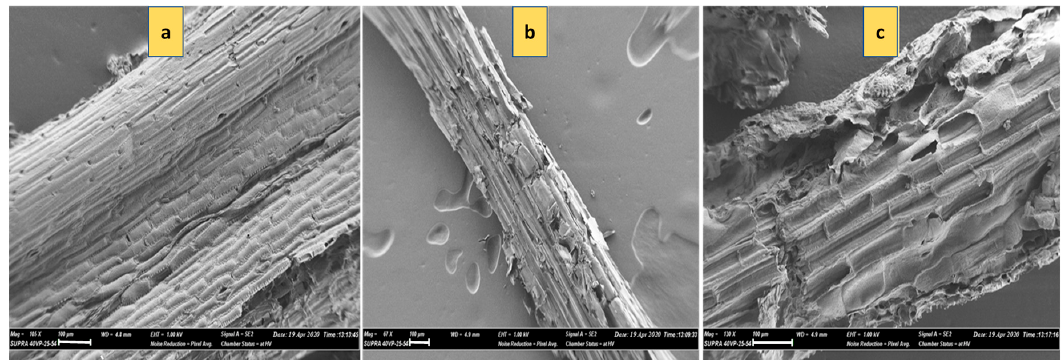
Figure 6. Scanning electron microscopy (SEM) images (scale bar 100 μ m) of unprocessed corn stover after 10 days of incubation at 60 °C, pH 7.0, and agitation speed of 150 rpm with ( a ) Control with 0% inoculum; ( b ) 5% inoculum of parental strain of WSUCF1; ( c ) 5% inoculum of Geobacillus sp. strain eWSUCF1.